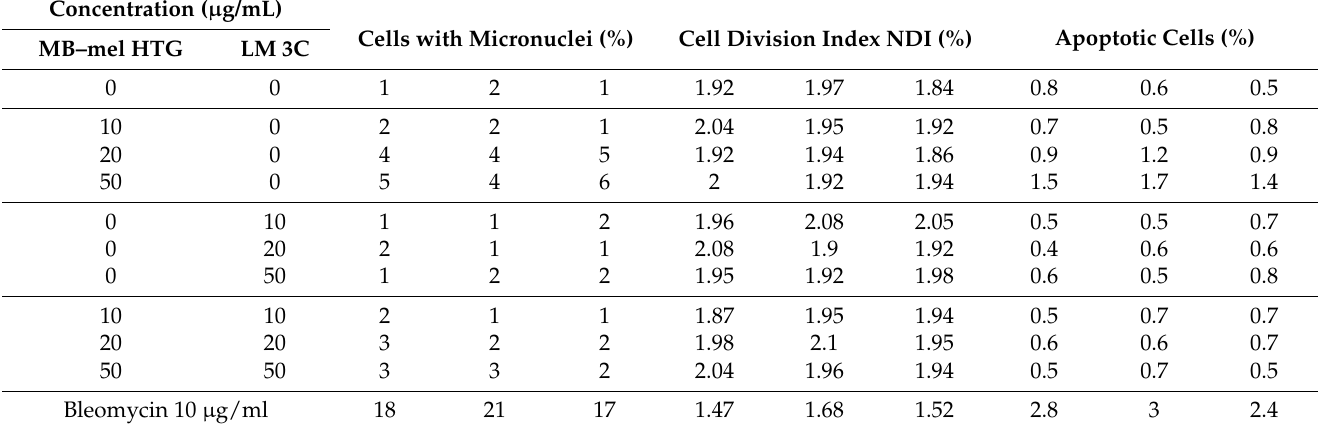
Table 7. The effect of advanced glycation end-products on SK-MEL